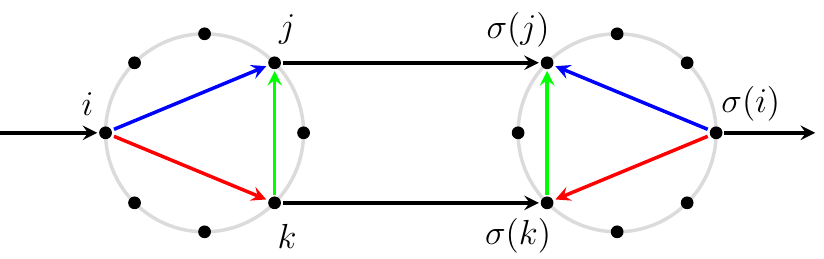
Figure 10. All index loops can be brought to have a uniform orientation by an even number of arrow (cid:13)ips. To get a uniform orientation of any external thread an odd number of arrows (cid:13)ips are